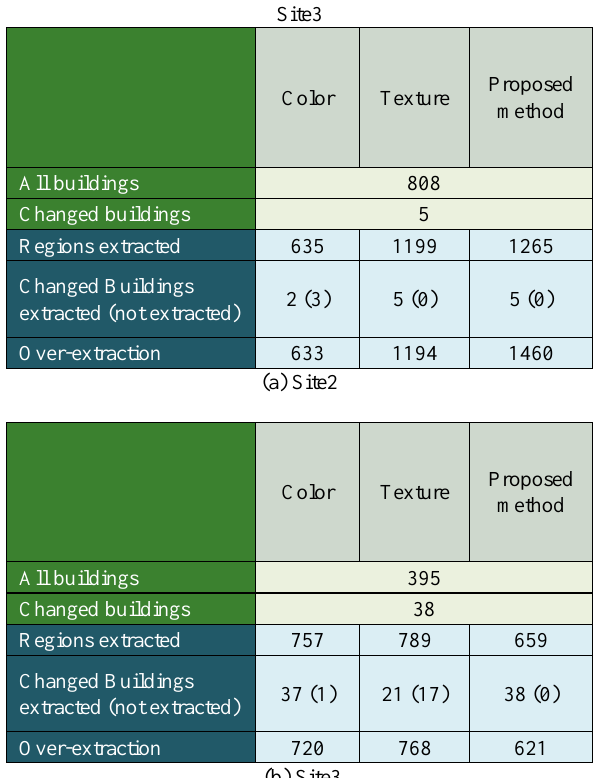
Table 7. Extraction results of changed buildings in Site2